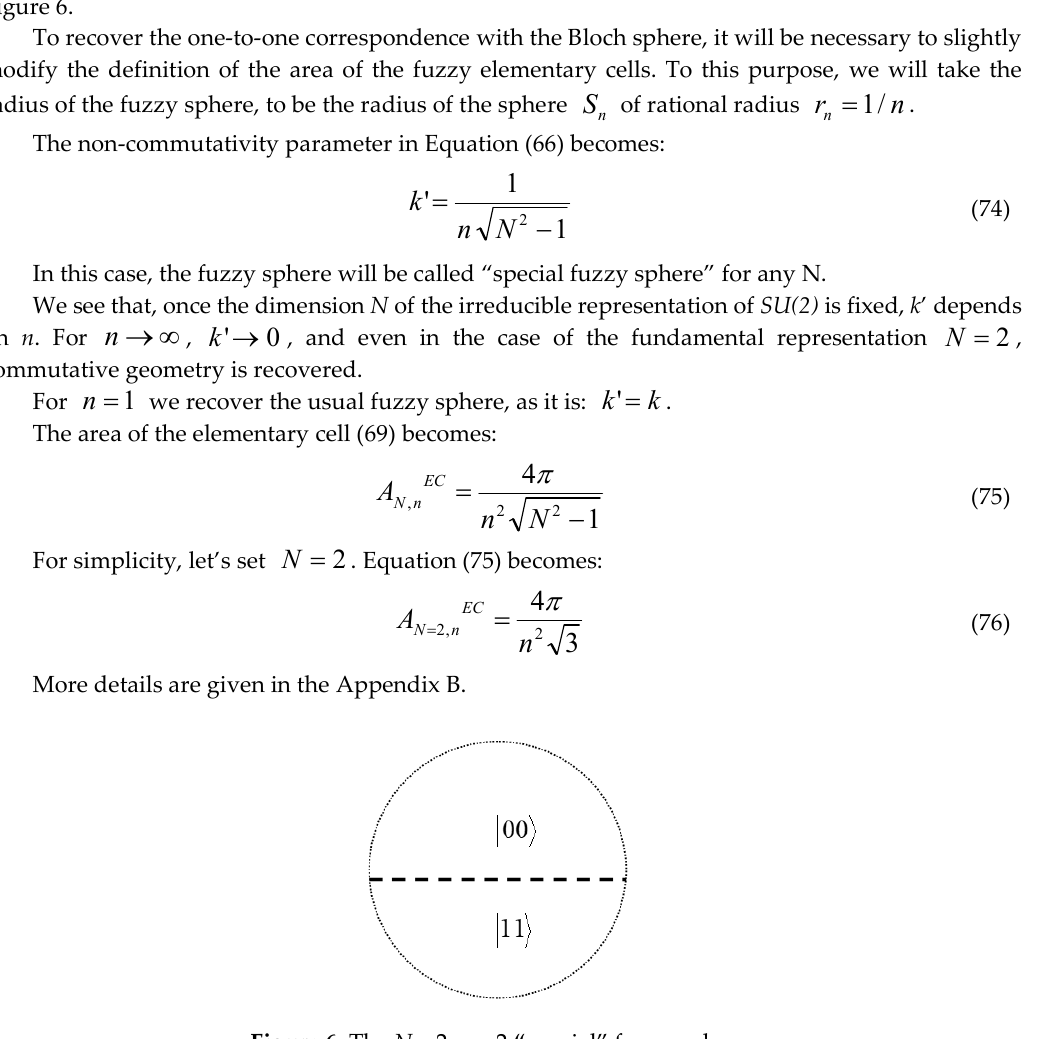
Figure 6. The N = 2, n = 2 “special” fuzzy